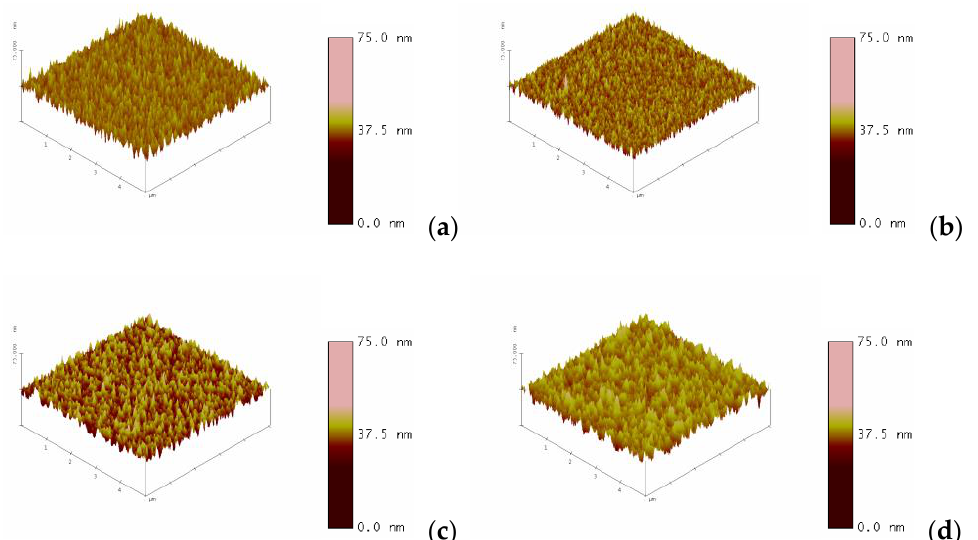
Figure 6. The surface micro-structure (AFM) images of the ITO X thin films prepared by different oxygen growth procedure parameters for ( a ) 0%( b ) 25% ( c ) 50%, and ( d ) 75%. The typical I–V curves of the ITO X thin films RRAM devices are shown in Figure